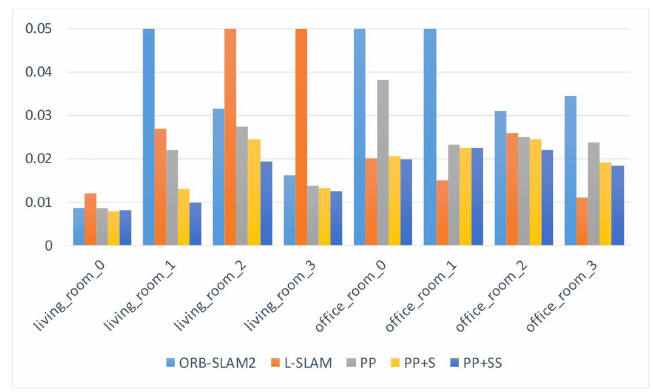
Figure 5. The comparison of the root RMSE on ICL-NUIM dataset.